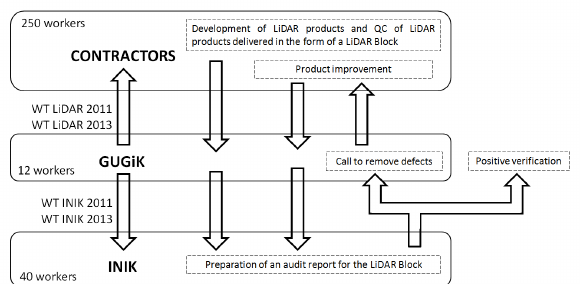
Fig ure 1. Scheme of the relations and informati on workflow in the ISOK project